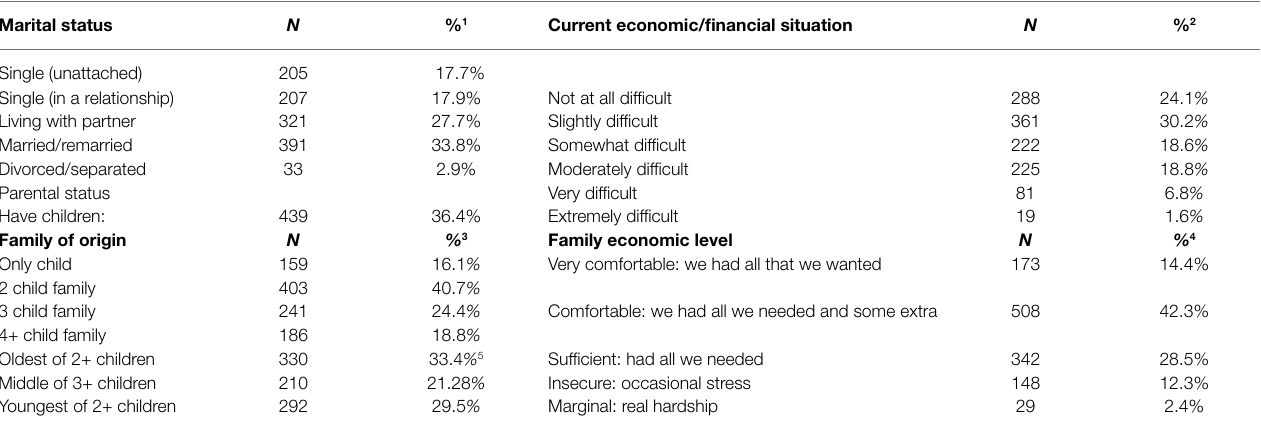
TABLE 2 | Trainees’ current life status and family background.